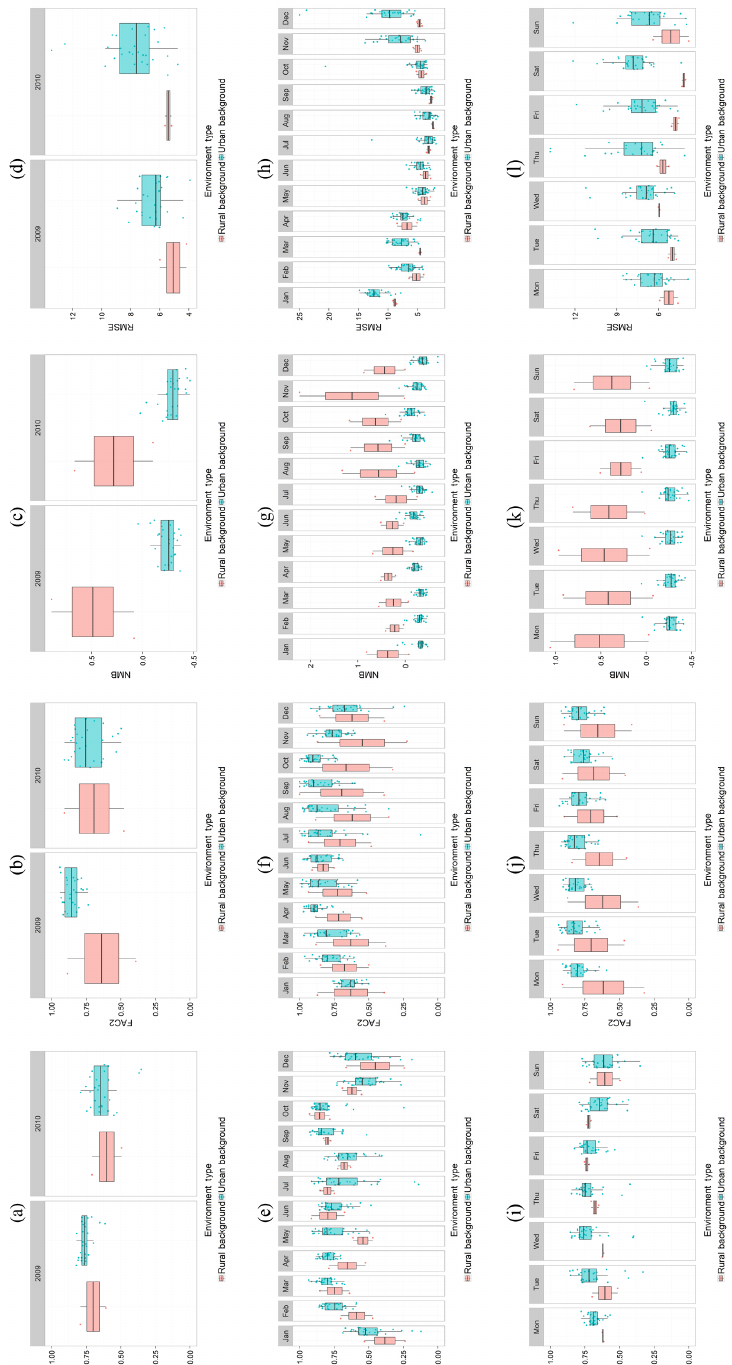
Figure 5. Model–measurement statistics per site for PM 2 . 5 daily mean concentrations during 2009–2010, by site type, and by (a–d) year, (e–h) month-of-year, and (i–l) day-of-week. (a) , (e) , and (i) are Pearson’s correlation coefficient ( r) ; (b) , (f) , and (j) are the fraction of data pairs within a factor of 2 (FAC2); (c) , (g) , and (k) are normalized mean bias (NMB); and (d) , (h) , and (l) are the root mean squared error (RMSE) in µgm − 3 . Dots show individual site statistics ( n = 2 and 28 for RB and UB sites, respectively), which are summarized in the superimposed box plot whose shading demarcates the interquartile range (IQR) and whose whiskers extend to the largest and smallest values within 1.58 × IQR from the box